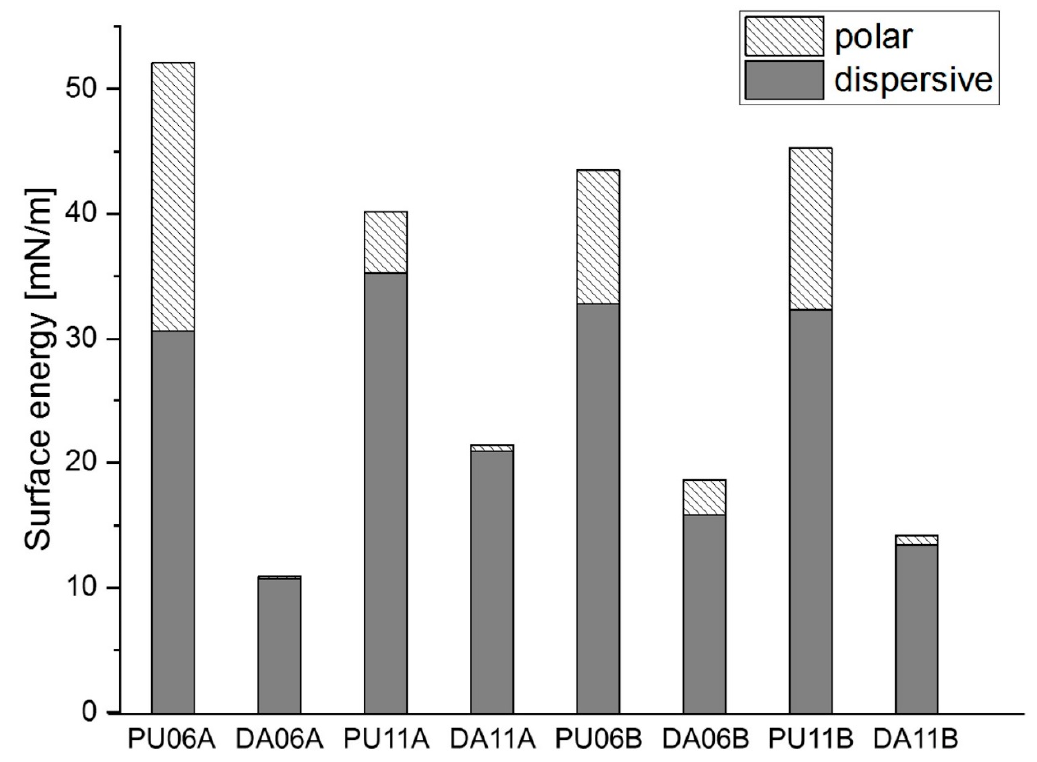
Figure 6. Surface energies of PUs and DA products.